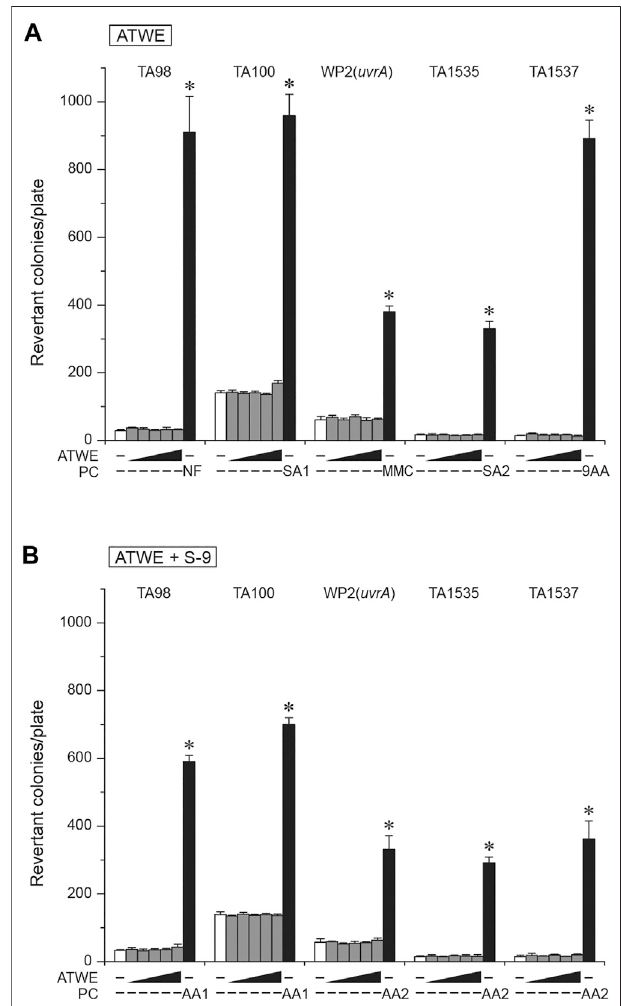
FIGURE 5 | Absence of mutagenicity in the bacterial reverse mutation test of Acer tegmentosum Maxim. water extract. Acer tegmentosum Maxim. water extract (ATWE) was tested on fi ve bacterial tester strains to evaluate mutagenic potentials. When treated with one of 0, 312.5, 625, 1,250, 2,500, and 5,000 µg/plate ATWE, (A) none of the tester strains showed an increase of revertant colonies compared to the vehicle controls except for a mild elevation in TA100 treated with the highest dose, and (B) metabolic activation of ATWE with S-9 mixture resulted in comparable levels of revertant colonies to the vehicle control in each tester strain, while positive controls signi fi cantlyincreasedthenumber.Whitebars;vehiclecontrol,darkgraybars; ATWE, black bars; positive controls, NF; 10.0 µg/plate 2-nitro fl uorene, SA1; 5.0 µg/plate of sodium azide, SA2; 0.5 µg/plate of sodium azide, 9AA; 80.0 µg/plate of 9-aminoacridine, AA1; 2.0 µg/plate of 2-aminoanthracene and AA2; 5.0 µg/plate of 2-aminoanthracene. *; p < 0.05 by one-way ANOVA followed by post hoc Dunnett ’ s